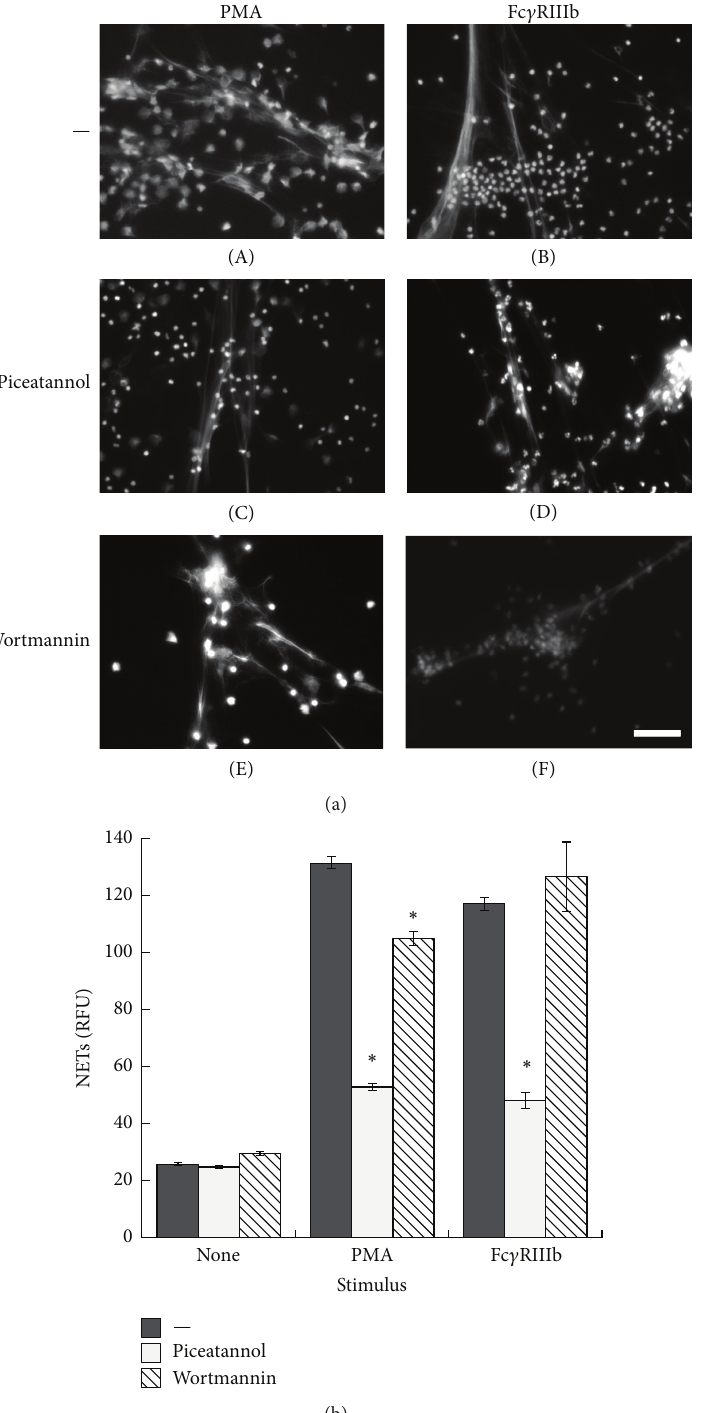
Figure 7: Fc 𝛾 RIIIb-induced NET formation requires Syk but is independent of PI-3K. (a) Human neutrophils (PMN) were not stimulated (None) or were restimulated with 20 nM phorbol 12-myristate 13-acetate (PMA) or by cross-linking Fc 𝛾 RIIIb with mAb 3G8. PMN were previously treated with solvent alone (—) or with the Syk inhibitor piceatannol (50 𝜇 M) or with the PI-3K inhibitor wortmannin (50 nM). After four hours, PMN were fixed and stained for DNA (DAPI). Microphotographs were taken at 200x magnification and are representative of three experiments. Bar is 50 𝜇 m. (b) The relative amount of NETs was estimated from SYTOX Green fluorescence in relative fluorescent units (RFU) at 4 hours after stimulation. Data are mean ± SEM of 5 experiments. Asterisks denote conditions that are statistically different from control ( 𝑝 < 0.05